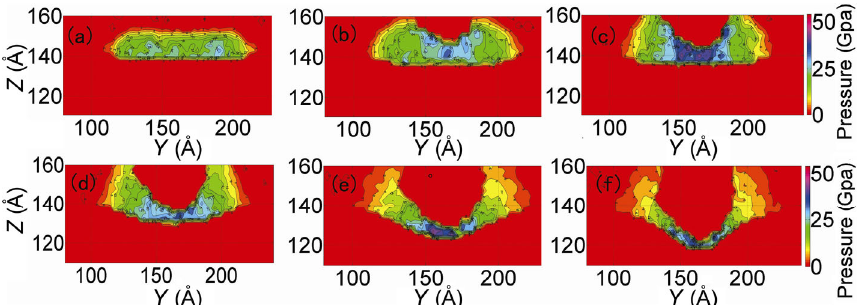
Fig. 10 Pressure distribution of water film confined at different moments under Pos20. Stage_I, Stage_II, and Stage_III range from 0–750 fs, 750–1,050 fs, and 1,050–1,950 fs, respectively. (a) 750 fs; (b) 900 fs; (c) 1,050 fs; (d) 1,300 fs; (e) 1,600 fs; (f) 1,950 fs.